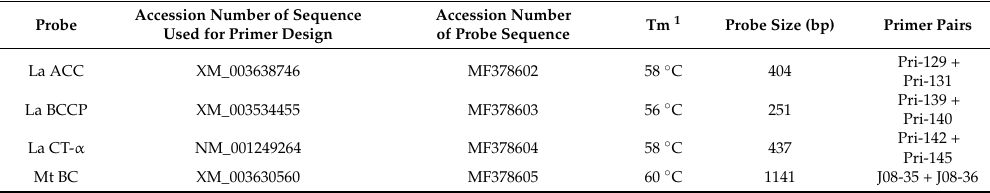
Table 1. Characterization of sequence-defined probes used for Lupinus angustifolius nuclear genome library